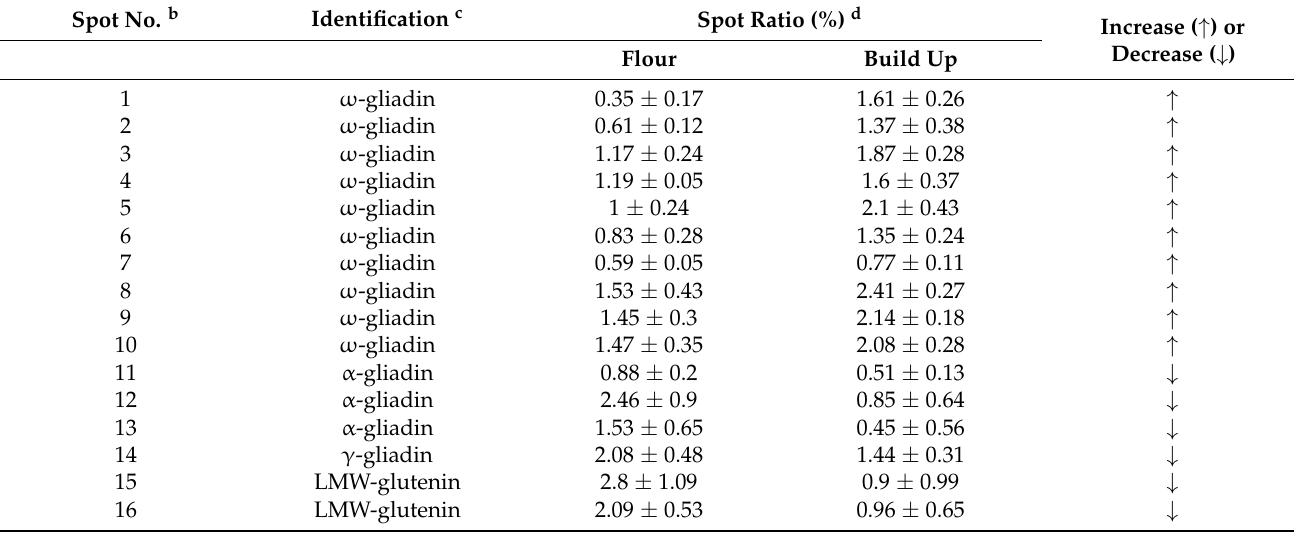
Table 6. The increased or decreased proteins in the monomeric protein extracted with 10% 1-propanol in LF a during mixing. Spot No. b Identification